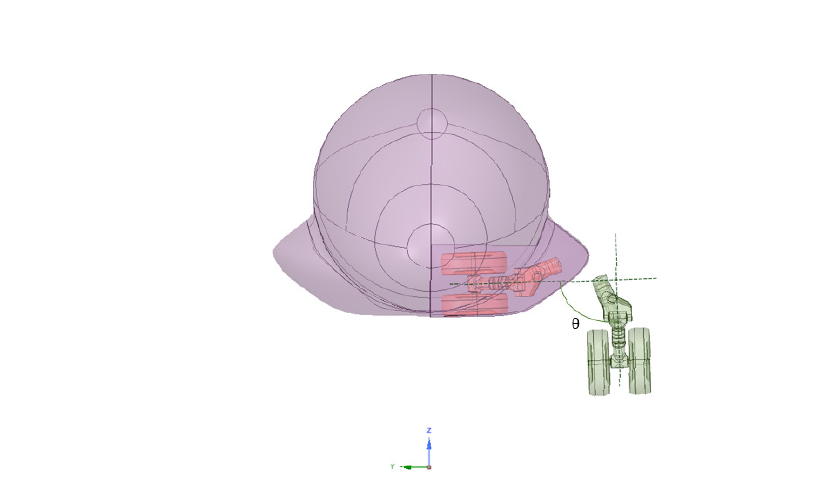
Figure 4. MLG: angular position of the gear strut, from stowed to deployed